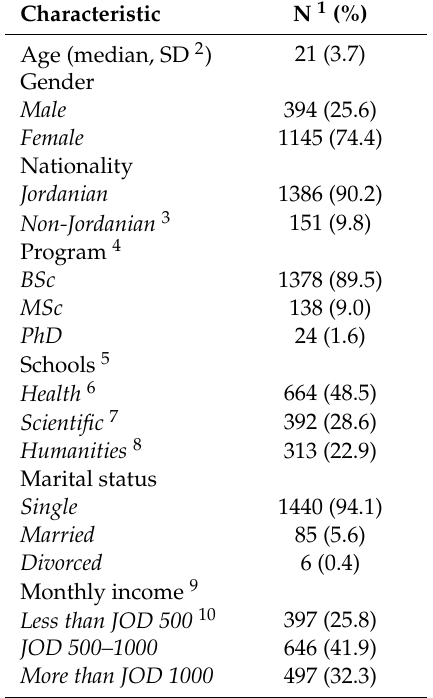
Table 1. Characteristics of the study